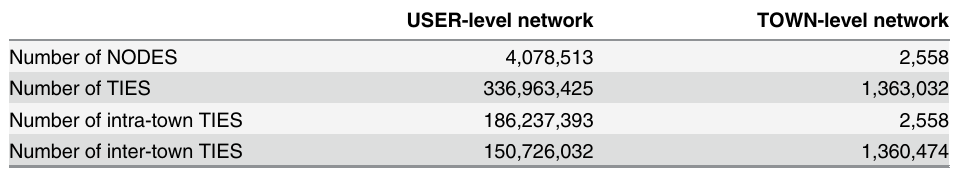
Table 1. Aggregation of the iWiW network to a town-level.